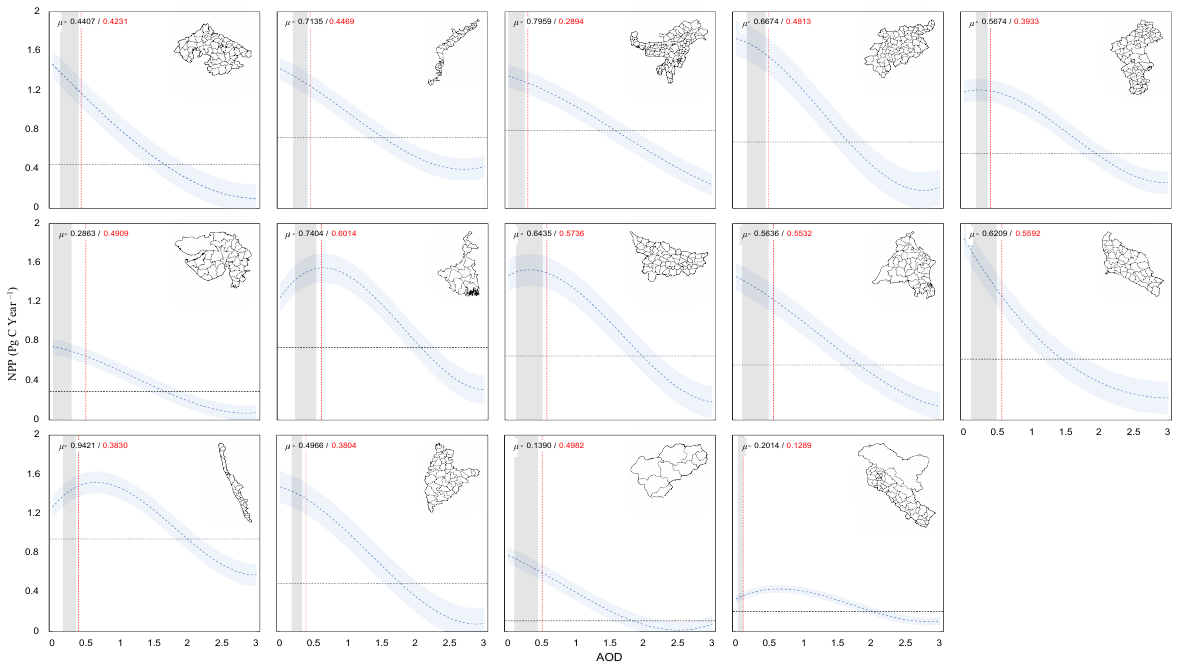
Figure 4. Relative sensitivity of NPP to AOD for different ecological zones of India for all-sky conditions. The horizontal black dashed line and the vertical dashed line represents the mean NPP and AOD of the regime, respectively. The blue dashed line with shades represents the sensitivity and its uncertainty. The black shaded zone indicates the optimal AOD that was observed with maximum ecosystem